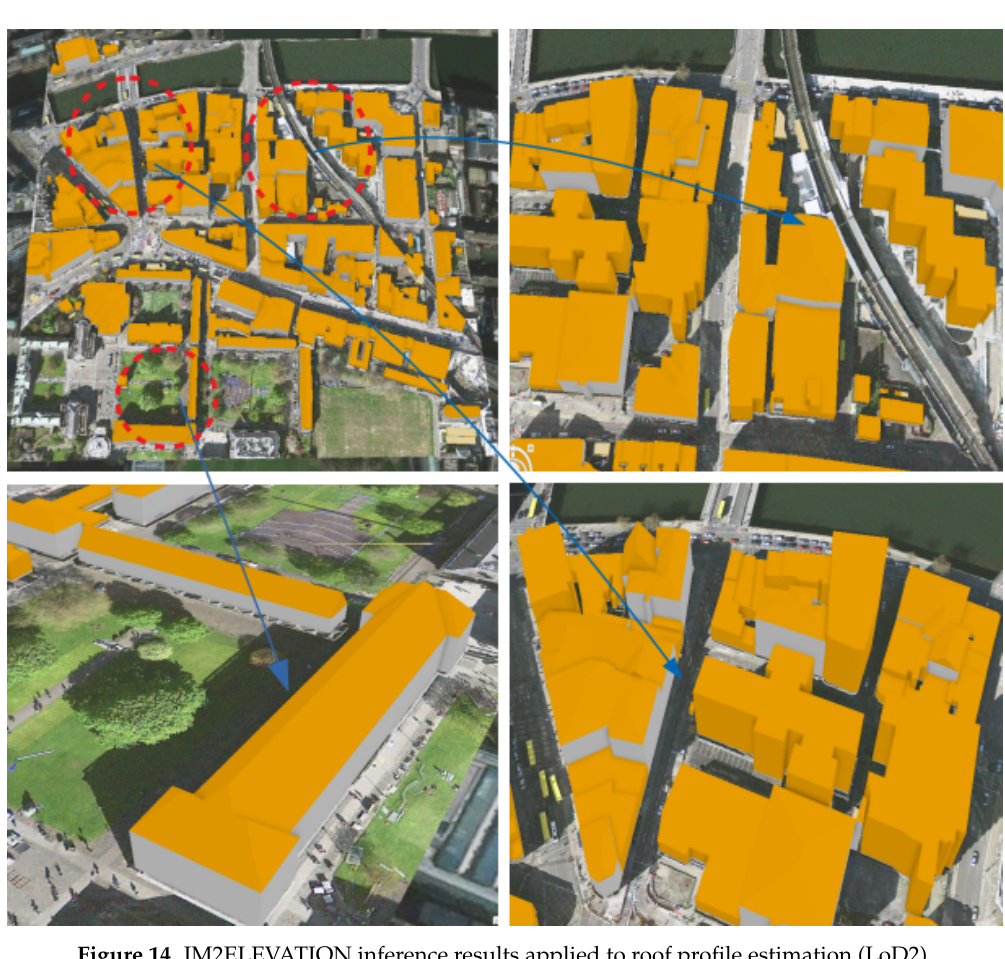
Figure 14. IM2ELEVATION inference results applied to roof profile estimation (LoD2).